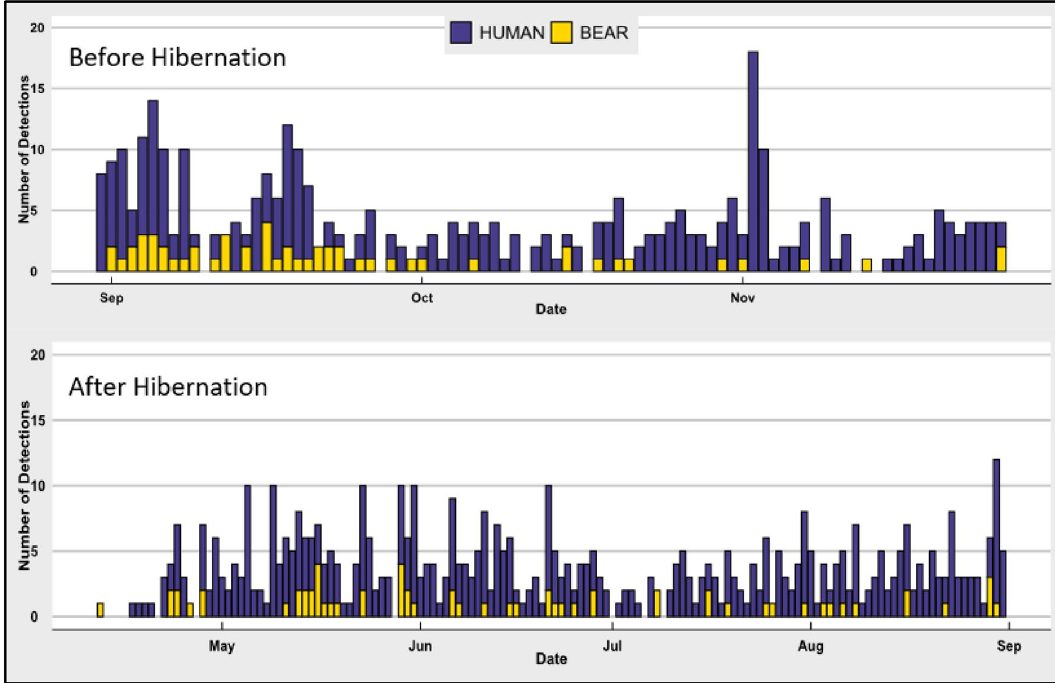
Figure 2. Summary of black bear and human detection history. Summary of when black bear and human detections were recorded throughout study period and further broken down into before hibernation (top), and after hibernation (bottom). The increase in human detection before hibernation in November represents deer hunting season.